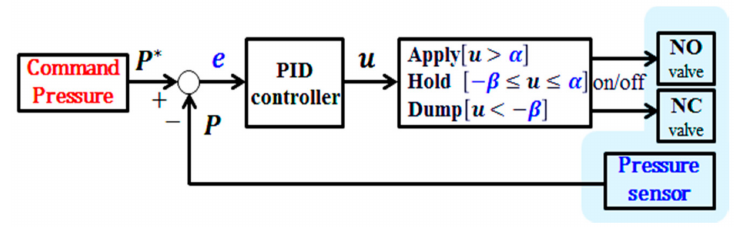
Figure 7. Conventional pressure control method with a simple switching